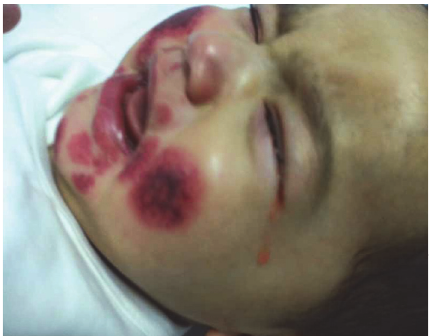
Figure 1: Bloody stained tears.